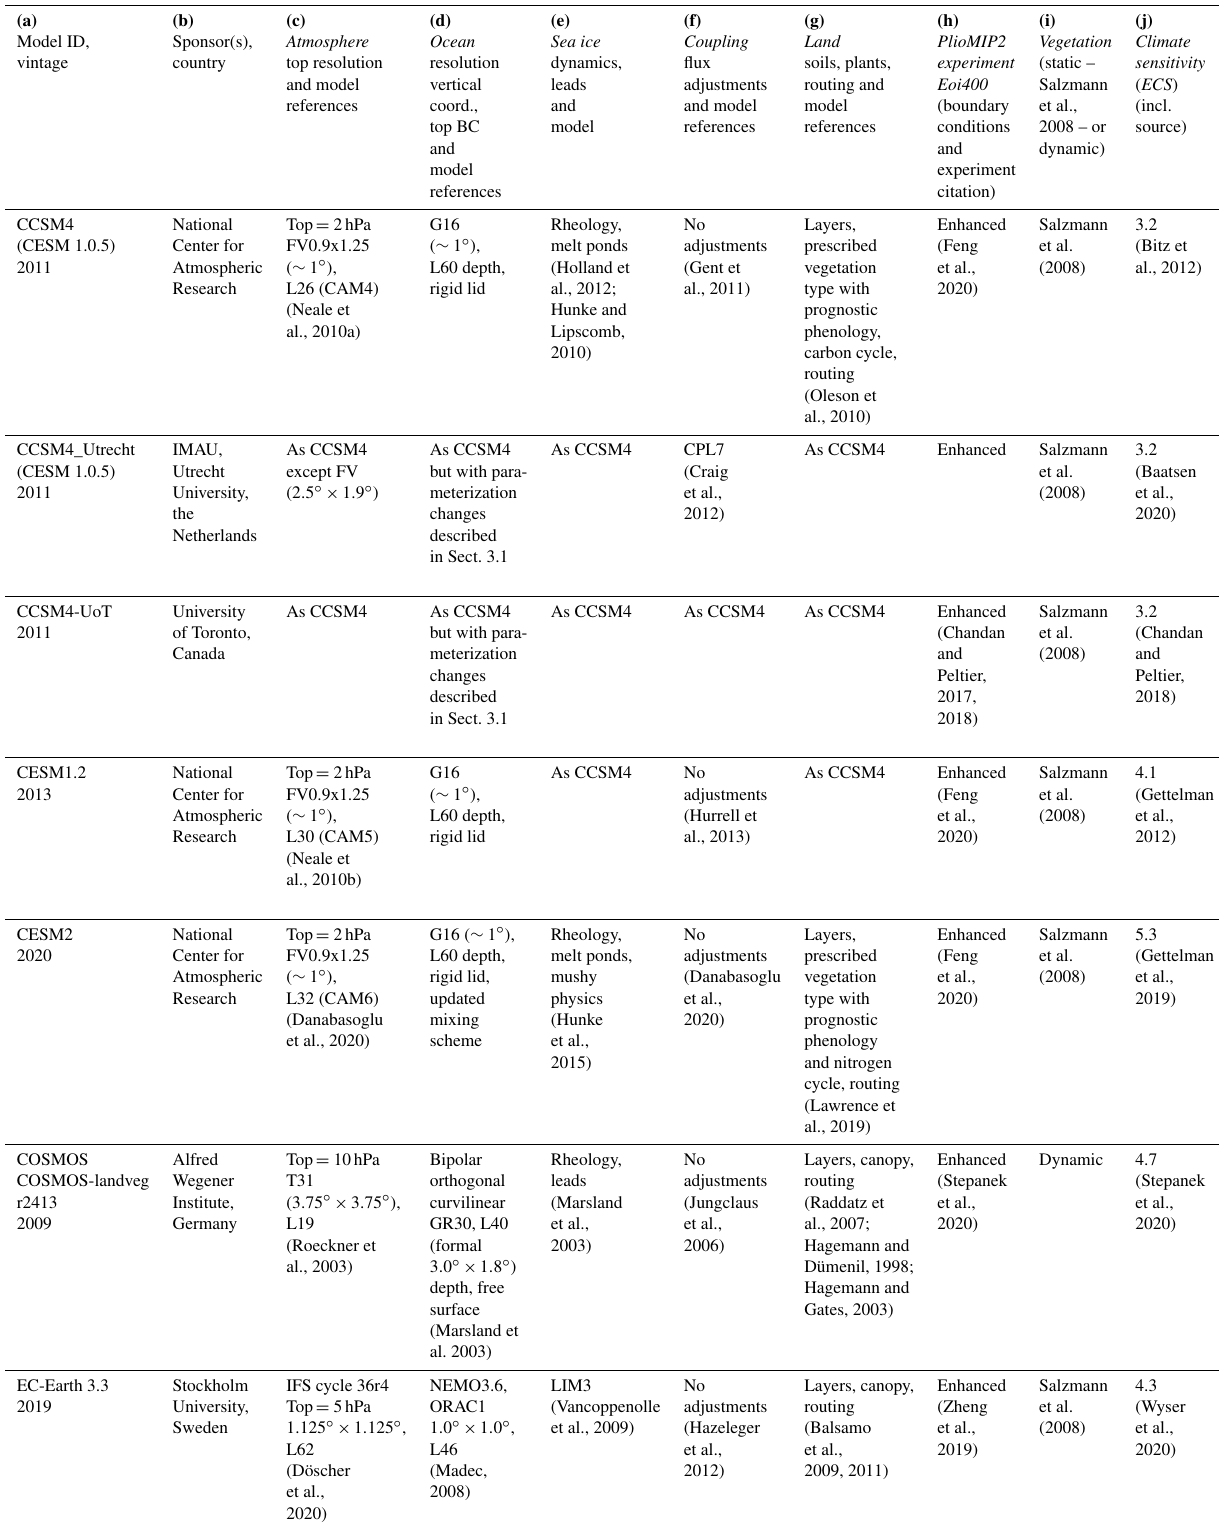
Table 1. Details of climate models used with the Plio Core experiment (a–g) plus details of boundary conditions (h) , treatment of vegetation (i) and equilibrium climate sensitivity values (j) ( ◦